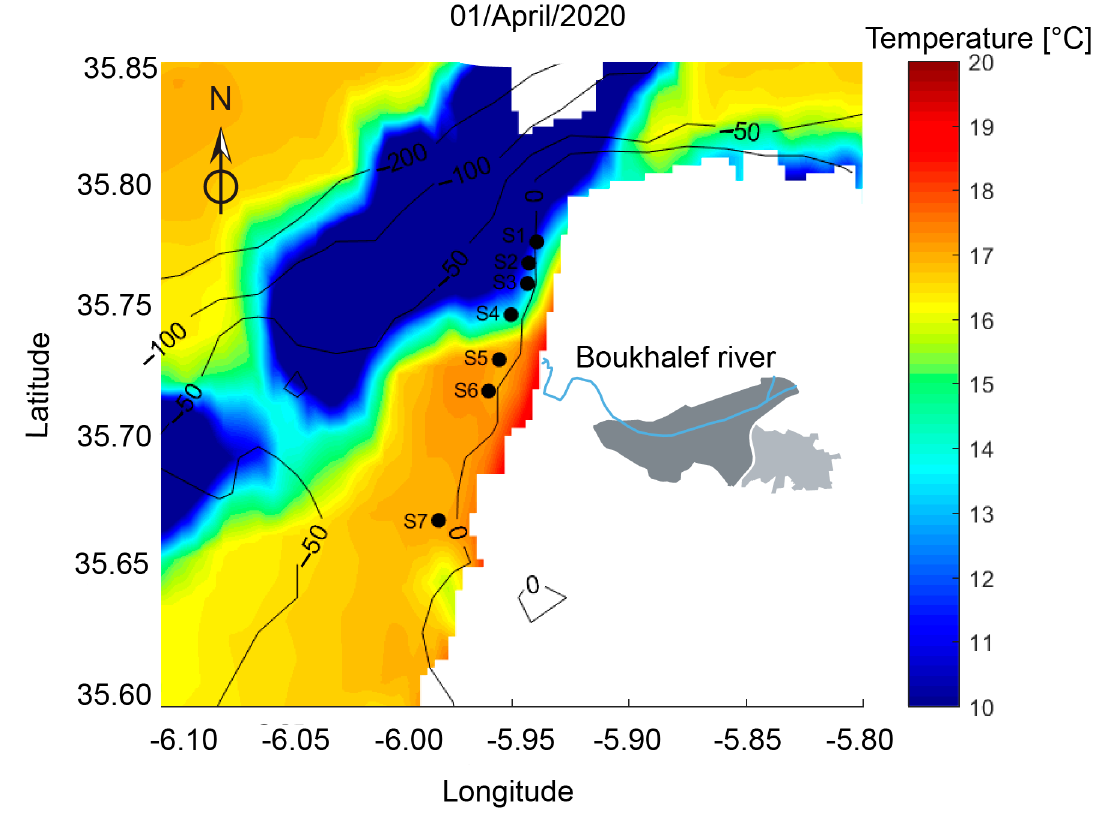
Figure 5. A preview of the sea surface temperature band included in the WST product.